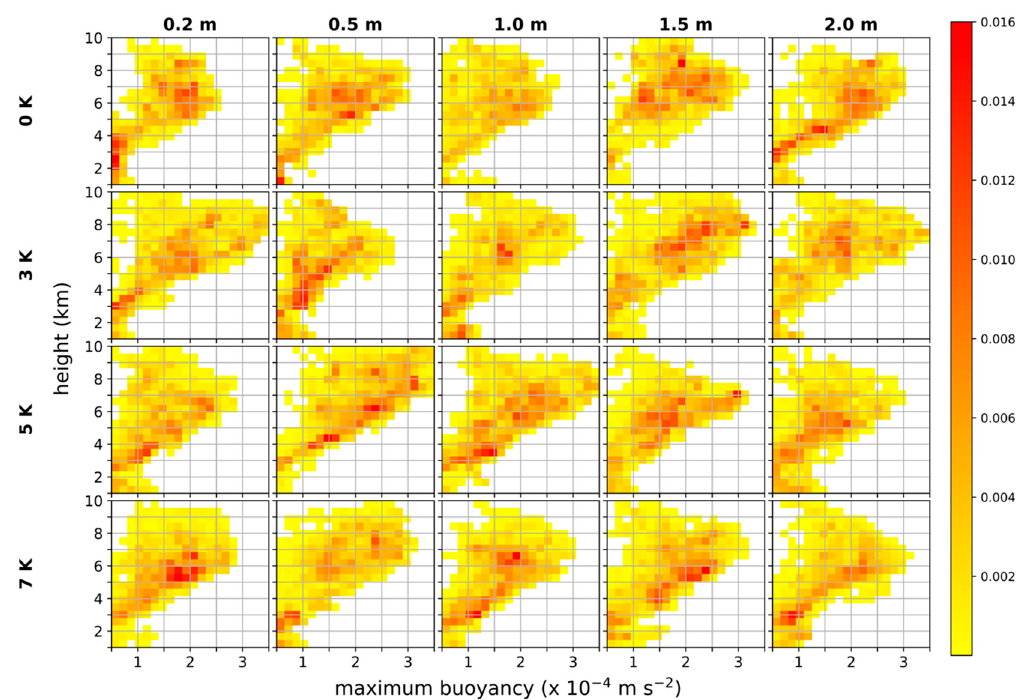
Figure 13. Same as Figure 12, except at t = 165 min.